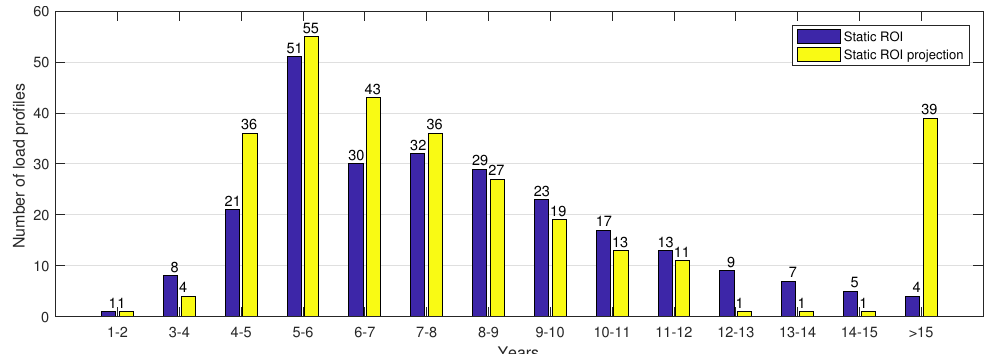
Figure 3. Static return on invest (ROI) of peak shaving storage systems in years based on 288 industrial load profiles analyzed by Smart Power in 2017 (blue), and the static ROI projection where the investment is reduced by 30% and the energy rate is raised by 30%